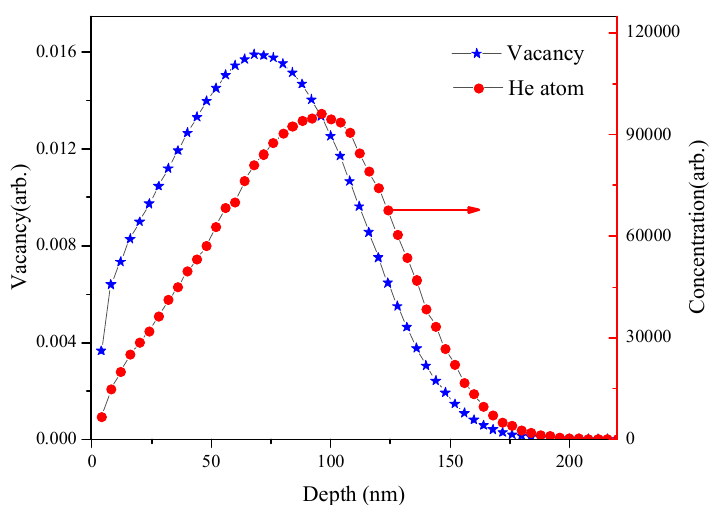
Figure 1. Depth profile of damage events and atoms distribution for 20 keV He-ions irradiated Fe9Cr alloy, calculated by SRIM.